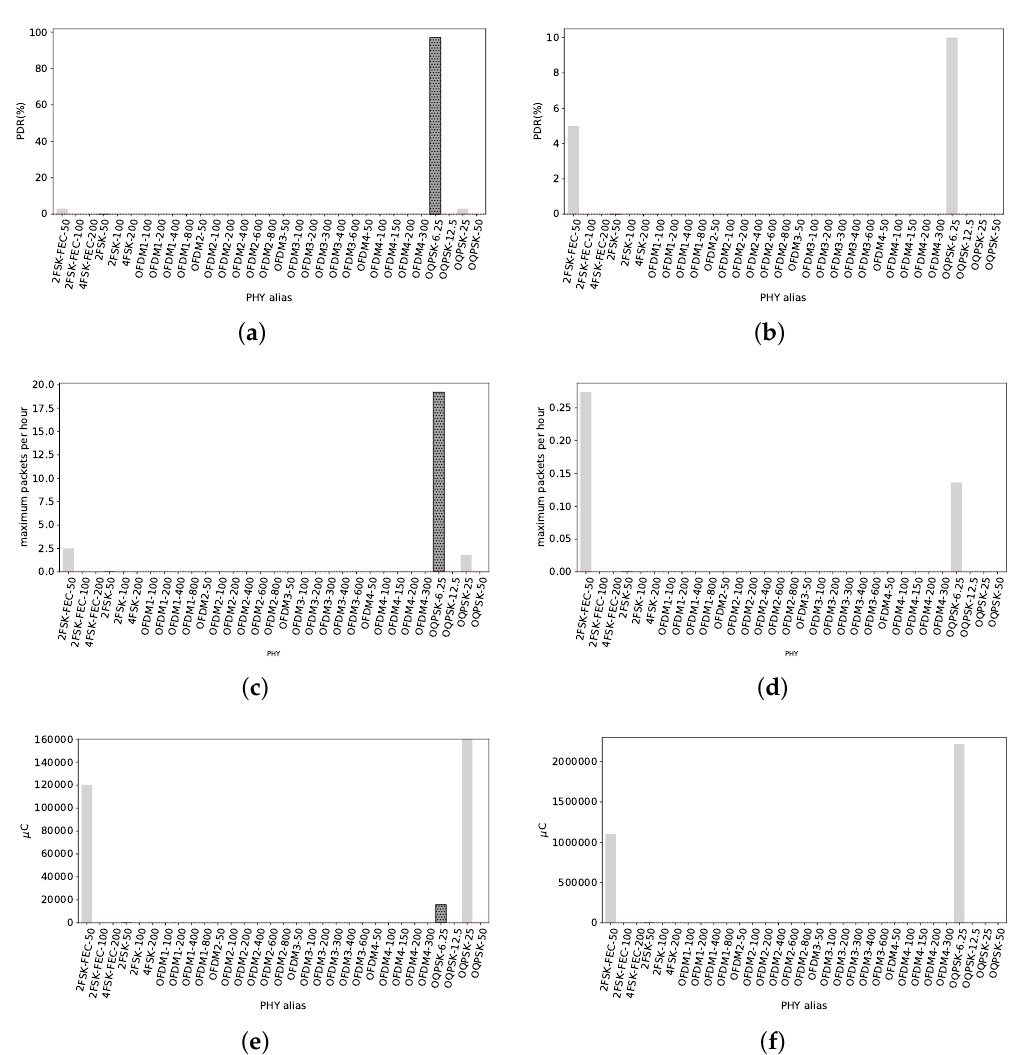
Figure 13. AMI, 350 m. Only the radio setting OQPSK-6.25 with short packets is useful for this type of challenging conditions, with several buildings between nodes. ( a ) PDR values considering packets of 127 B. Only OQPSK-6.25 can provide good connectivity with 97% PDR. The rest of the radio links offers no connectivity at all, PDR values of 0%; ( b ) PDR values with long packets of 2047 B. The quality of the radio link is overall poor. With PDR values below 10%, no communication link is possible; ( c ) Maximum amount of TX packets per hour. OQPSK-50 can roughly send 19 packets per hour. 2FSK-FEC-50 only 2 and OQPSK-25 only 1. The rest of the PHYs cannot get even one packet across; ( d ) Maximum amount of TX packets per hour. Any radio setting is able to send one packet; ( e )